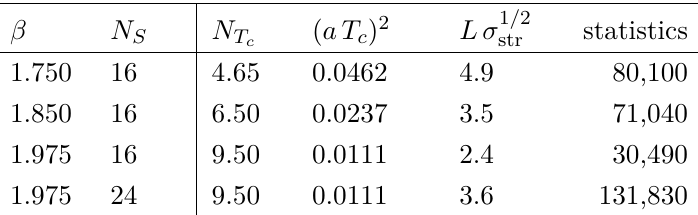
Table 1 . The simulation parameters. T c denotes the critical temperature. N T ref. [31]. The uncertainties of N